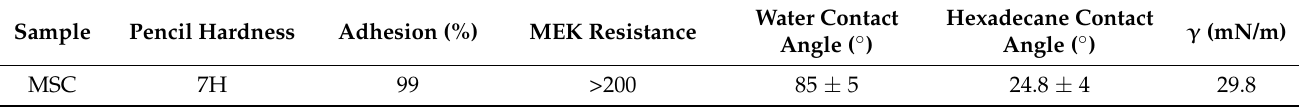
Table 2. Surface properties of the UV-cured MSC coating.